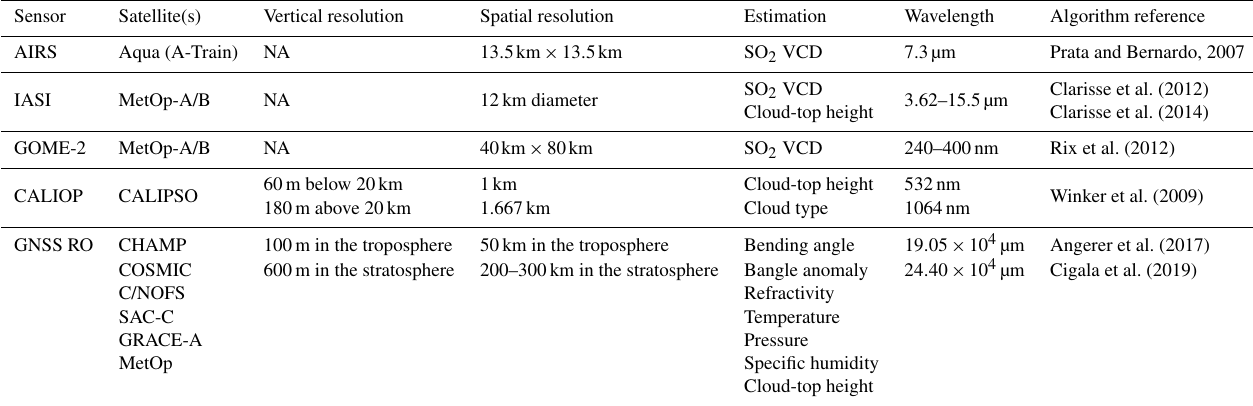
Table 1. Summary of data used to build the archive. Sensor Algorithm